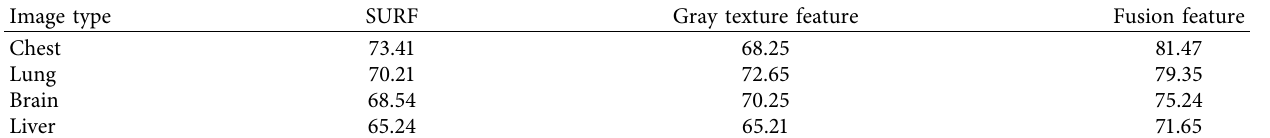
Table 3: Comparison of feature precision rates of medical images in different parts.